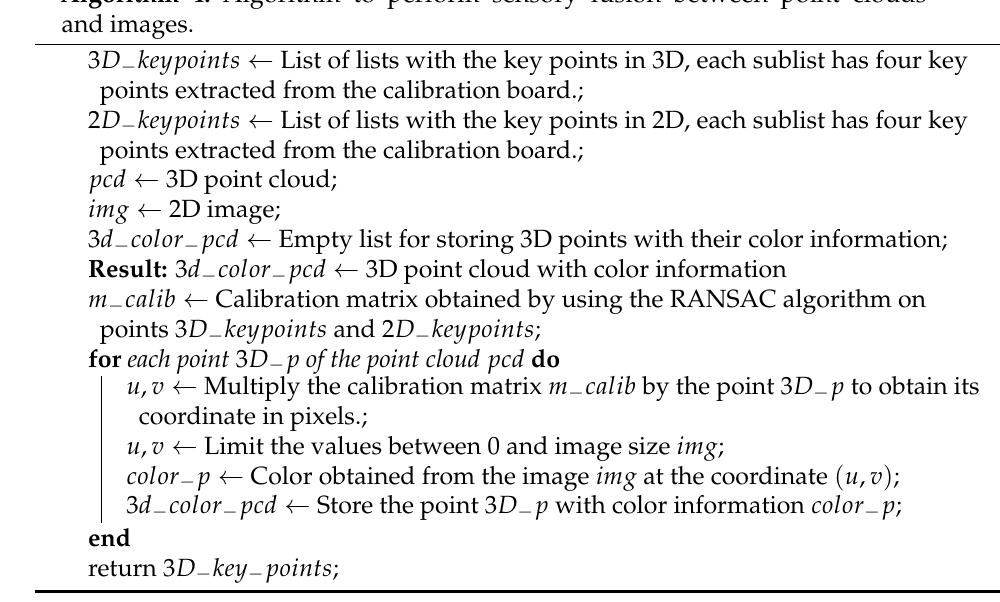
Algorithm 4: Algorithm to perform sensory fusion between point